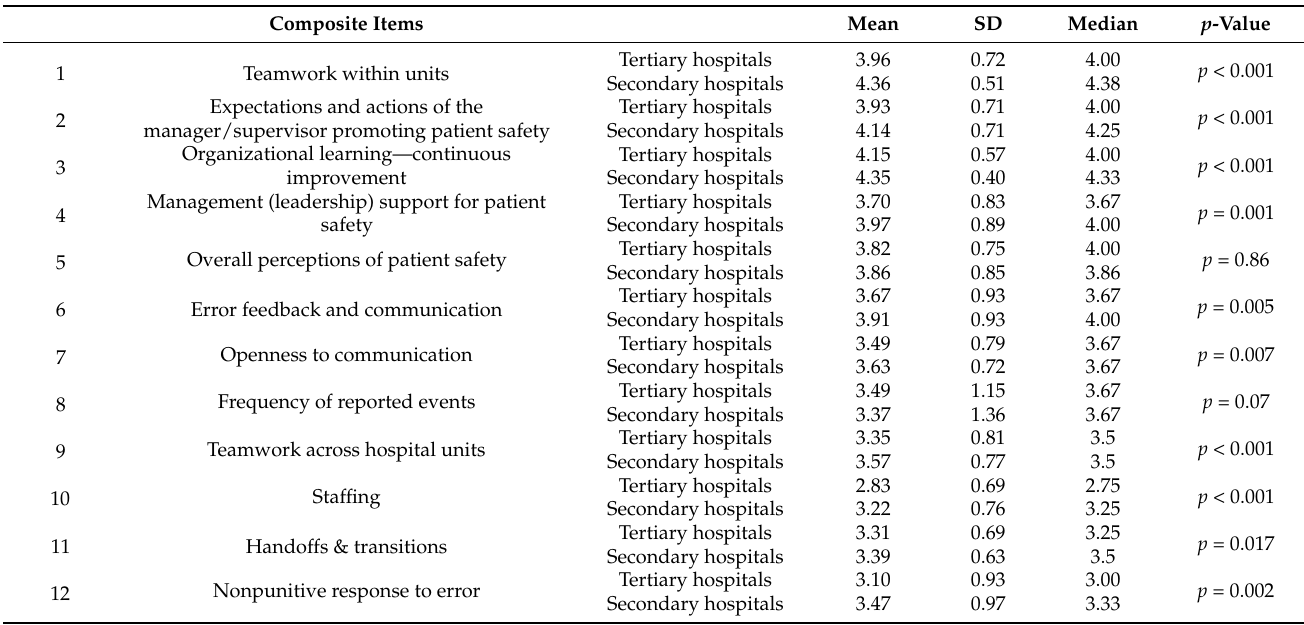
Table 3. Comparing employees’ perceptions of AICDs from tertiary hospitals ( n = 749) to employees’ perceptions of AICDs from secondary hospitals ( n = 178).